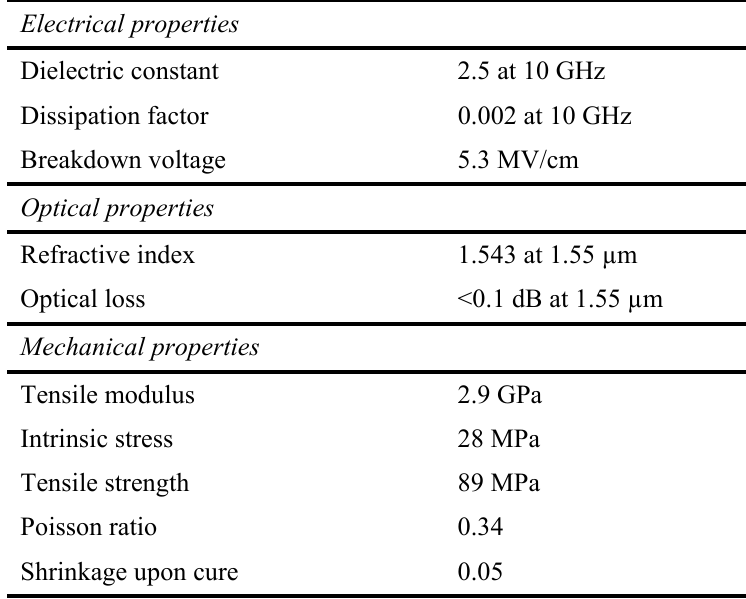
Table 1. Overview of the DVS-BCB die-to-wafer bonding process